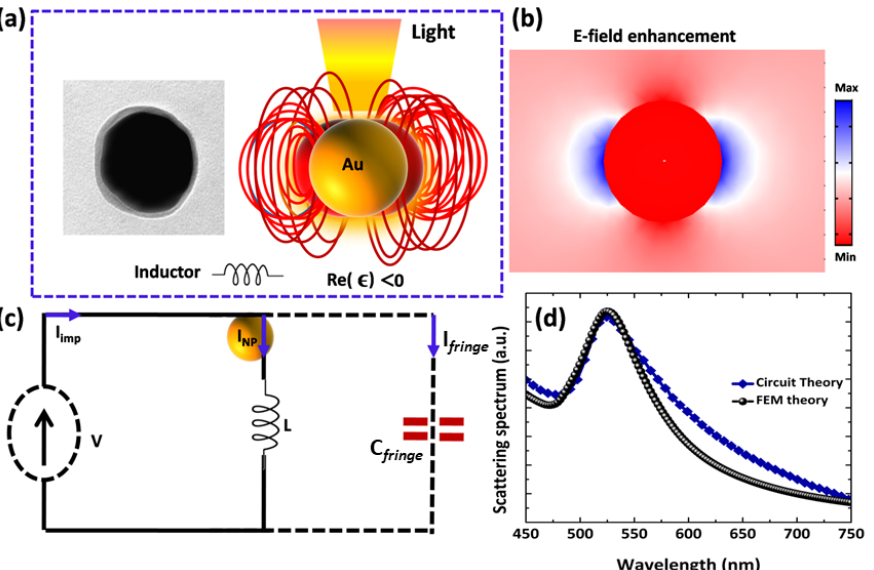
Figure 5. ( a ) TEM image and a schematic of an individual Au sphere inserted in surrounding medium. Simulated fringe dipolar field lines around the Au NP are negative ( b ) with optical scattered localized field enhancement. ( c ) A plasmonic nanoinductor based on Au NP realizing a lumped LC circuit and obtained from Thevenin-equivalent model. ( d ) Comparison between the scattering spectrum obtained with FEM based simulations (black line) and the response calculated by nanocircuit theory (blue line; amplitude of the current flowing in the circuit ( c